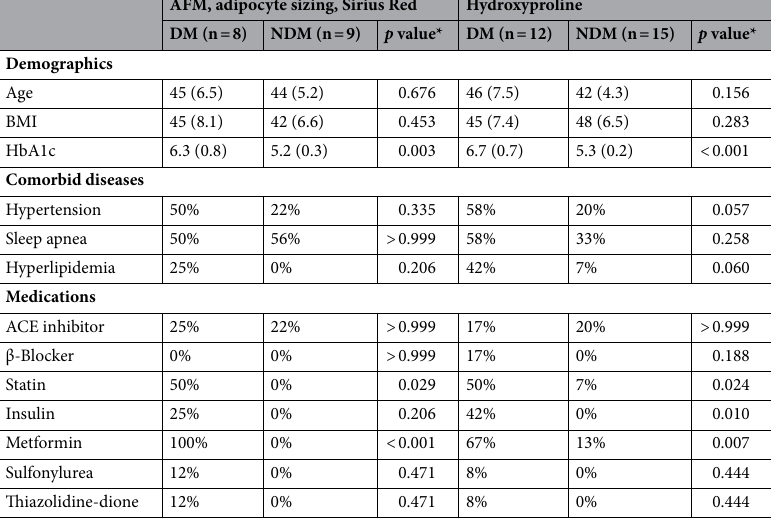
Table 1. Subject demographics. *Independent t-test and Fisher’s exact test were used to compare continuous and dichotomous variables respectively between DM and NDM groups; age (years), BMI (kg/m 2 ), and HbA1c (%) shown as mean with standard deviation in parentheses.